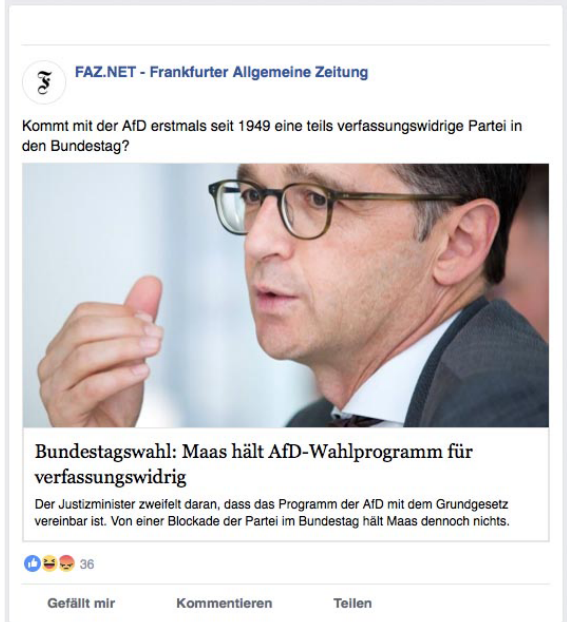
Figure 1. Example screenshot of an AfD-critical post with genuine